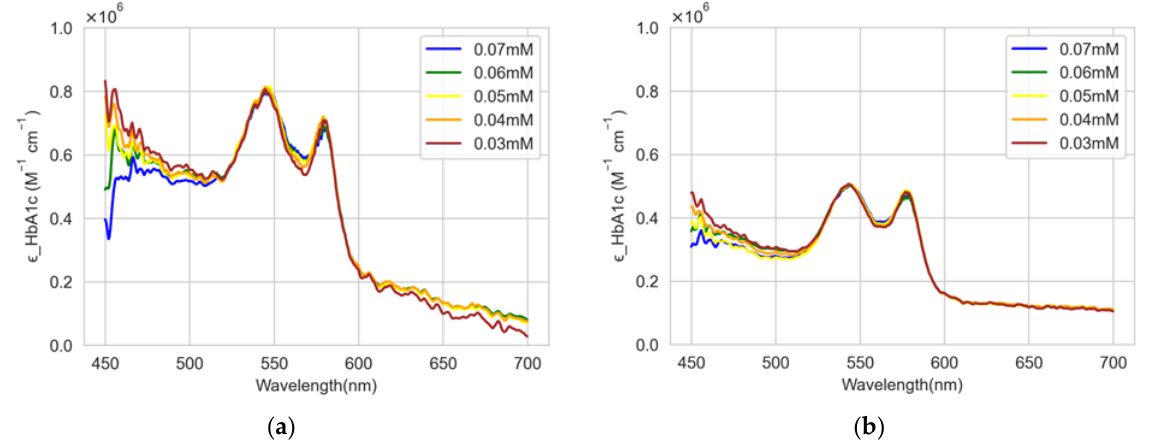
Figure 7. Calculated molar absorption coefficients from the experimental absorbance data. ( a ) Level 1; ( b ) Level 2.